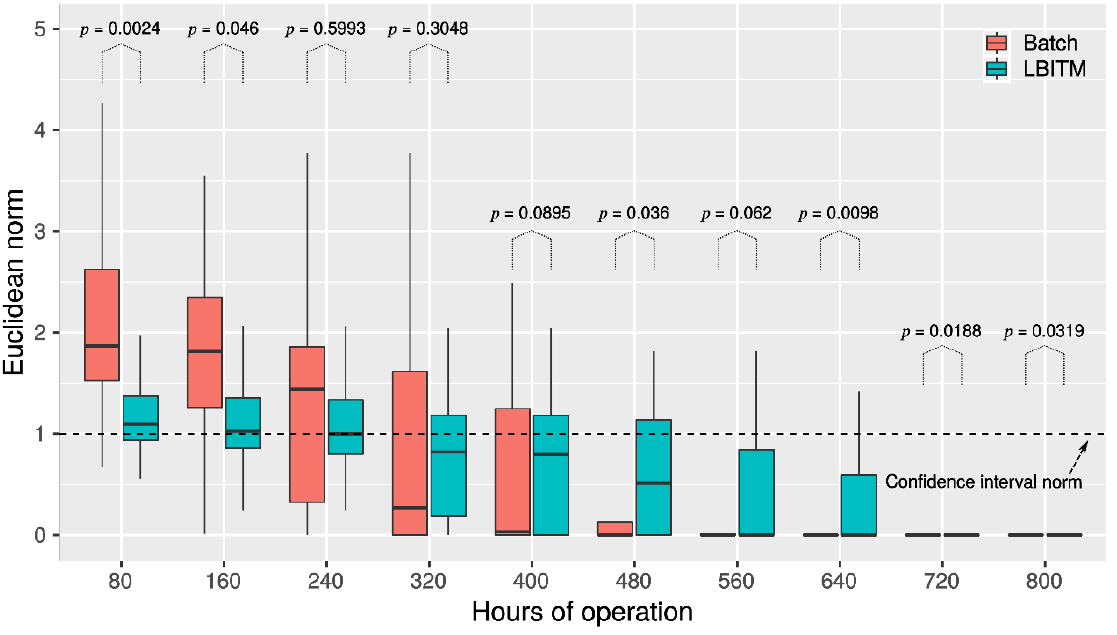
Figure 2. The evolution of the estimation representing every 80 h of operation for the batch estimation and for the LBITM for building A with an endemic prior. The graph has been normalised considering an estimation error equal to 1. The error was considered the Euclidean distance between the matrices. The series from building A were used to obtain the endemic prior. The boxes represent 50% of the data and the whiskers